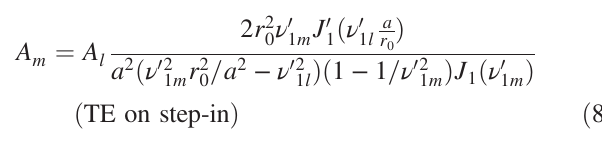
and Eq. (72) for E ϕ , with the r Þ ; B n n